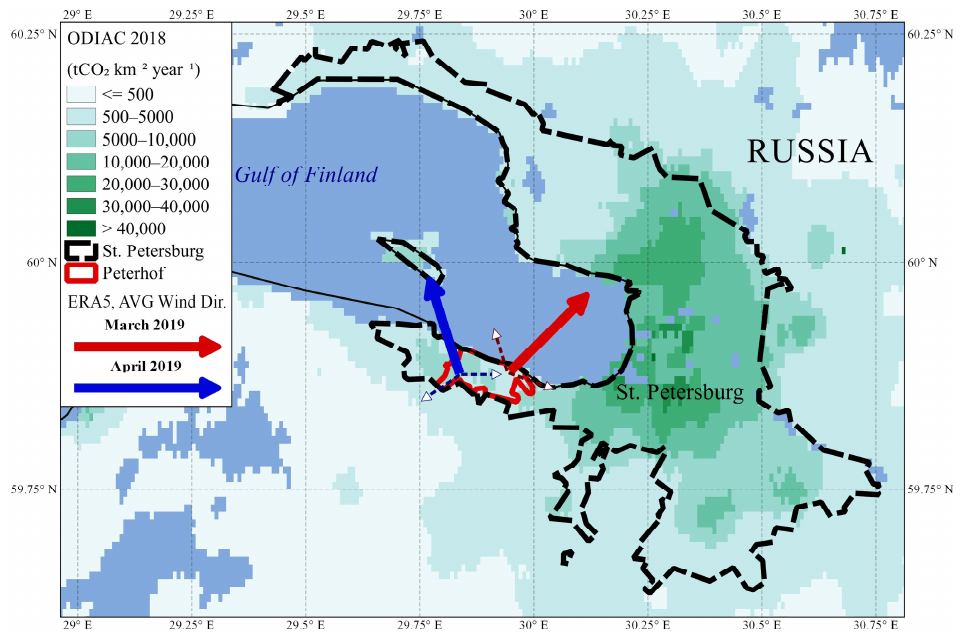
Figure 2. Anthropogenic CO 2 emissions from the high spatial resolution ODIAC (2018) and monthly averaged (March and April 2019) wind direction at 10 m and its standard deviation (dotted arrows) for the territory of Saint Petersburg and Peterhof